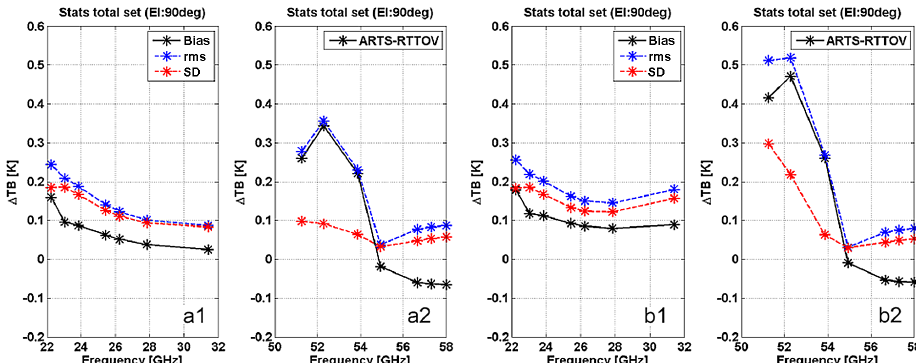
Figure 5. Bias (black solid line), standard deviation (red dashed line), and rms (blue dashed line) of TB differences between RTTOV-gb and the reference radiative transfer model ARTS (Eriksson and Buehler, 2015), for both clear (a1–2) and cloudy (b1–2) sky conditions (ARTS minus RTTOV-gb). Panels (a1, b1–a2, b2) are for K- and V-band channels, respectively. All panels report results at 90 ◦ elevation angle.